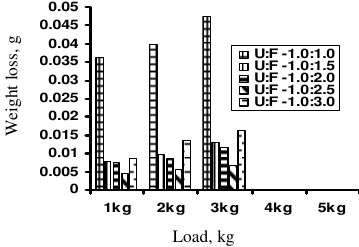
Figure 1(c). Wear strength results of different ratios of UF